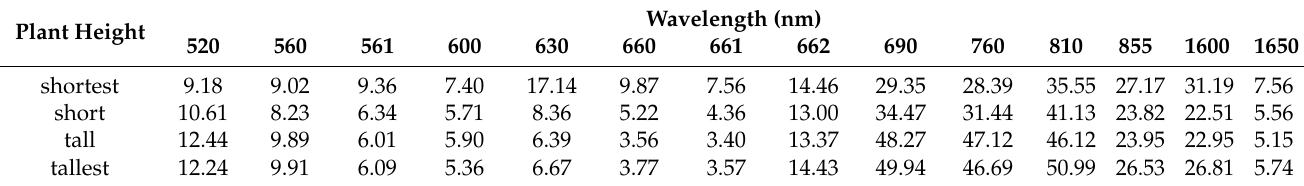
Table 5. Spectral reflectance of Klutuk, based on its size, from shortest to tallest.